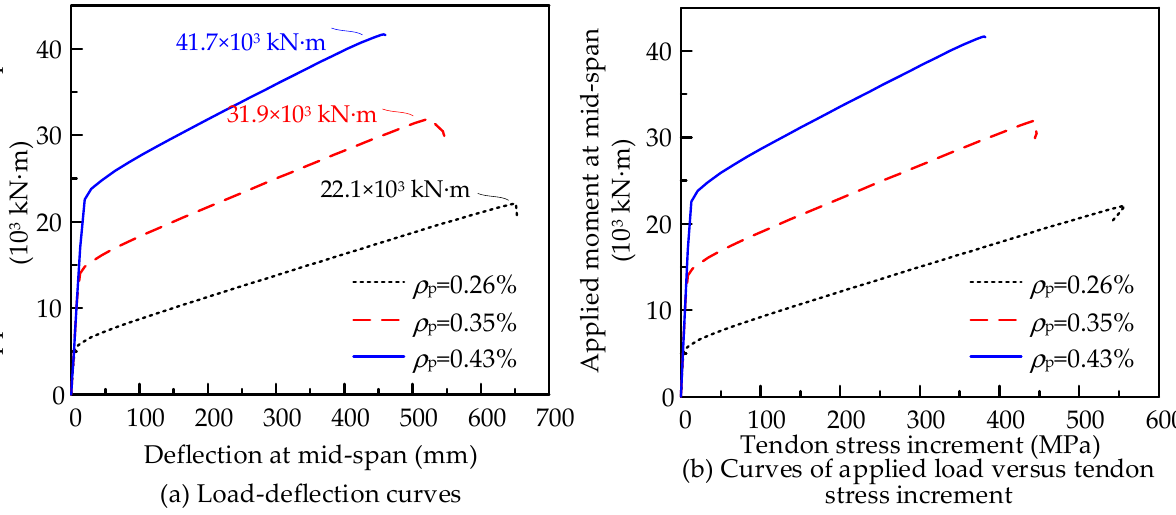
Figure 16. Effects of span-to-depth ratio L / d p on the flexural behaviors of PSCBIU-CFRP. (3) Prestressing reinforcement ratio ρ p Based on the referenced beam in Figure 13b, the area of the tendon is taken as the variable to discuss the effects of ρ p on the flexural performance. The cross-sectional area per tendon is set to 1575, 2100, and 2625 mm 2 , respectively. Three models are built with prestressing reinforcement ratios ρ p of 0.26%, 0.35%, and 0.43%. Under three-point loading states, the flexural behaviors are analyzed and the results are presented in Figure 17. With ρ p increasing by 65.4%, the flexural capacity increases by 88.7%. However, we also observe that the ultimate stress increment and the structural ductility decrease by 25.2% and 29.6%, respectively.